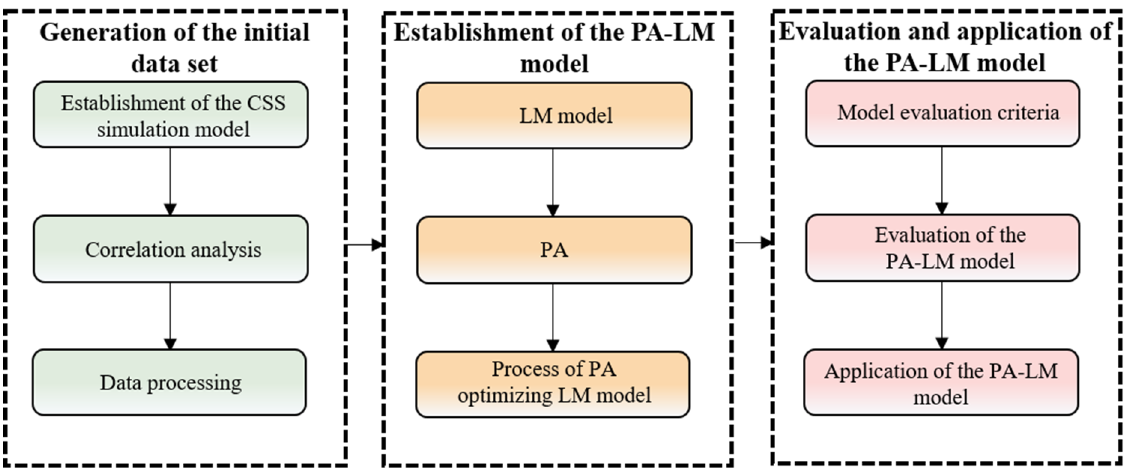
Figure 1. The workflow of the methodology combining the PA and LM model for predicting the COP of CSS horizontal wells.